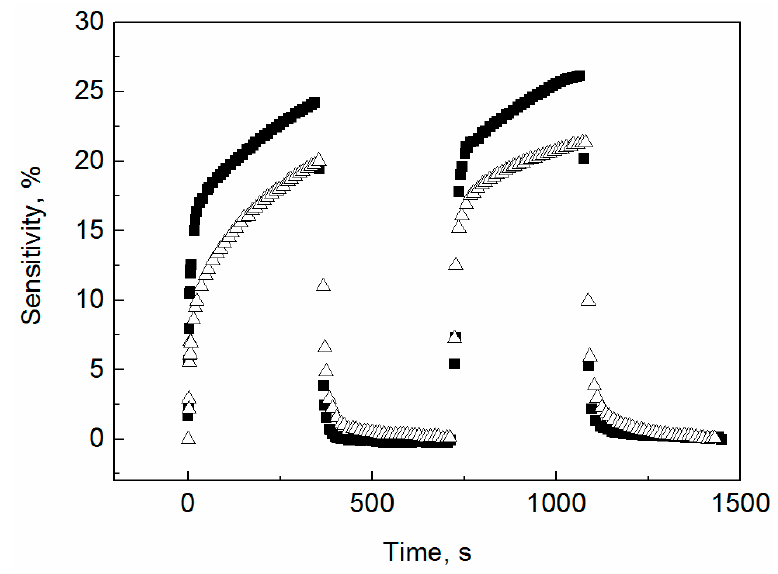
Figure 6. The response profile during two adsorption/desorption cycles in the presence of ethanol (7.7 vol %) for ( (cid:52) ) polypyrrole nanotubes and ( (cid:4) ) carbonized polypyrrole nanotubes.